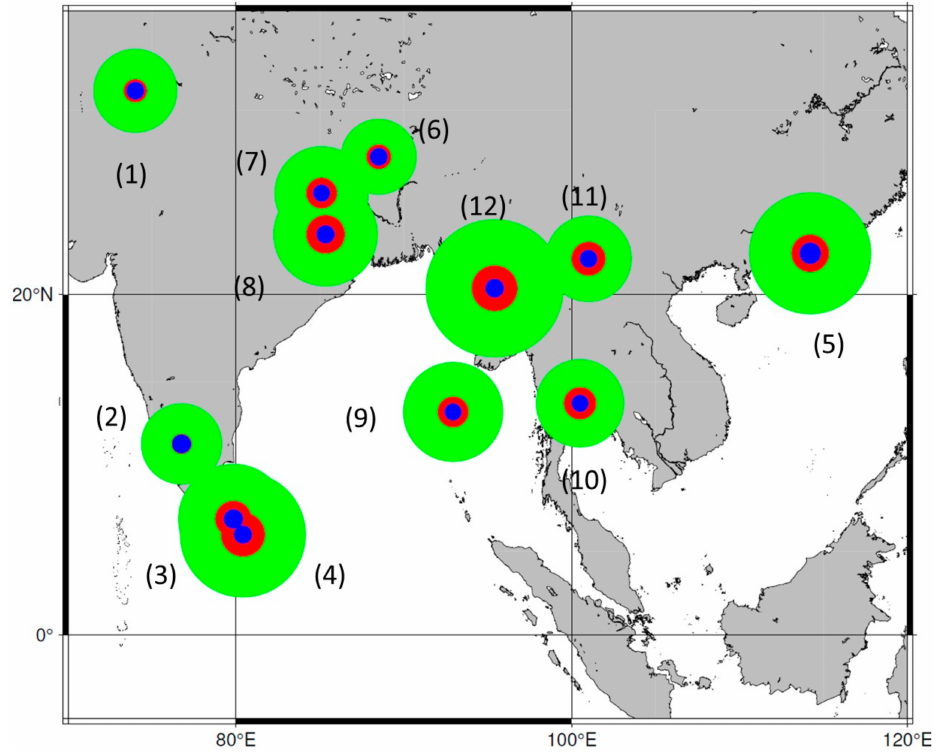
Figure 12. Phoenix heterogeneity in taxa from Middle and East Asia. The red and green circles are proportional to the heterogeneity of the group, before and after normalization, and the blue circles are proportional to the mean intraindividual variability of the accessions in each group.